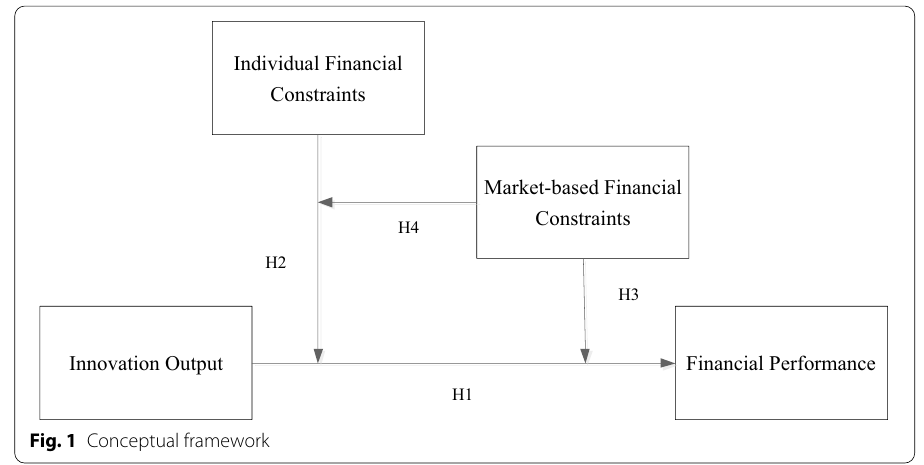
Fig. 1 Conceptual